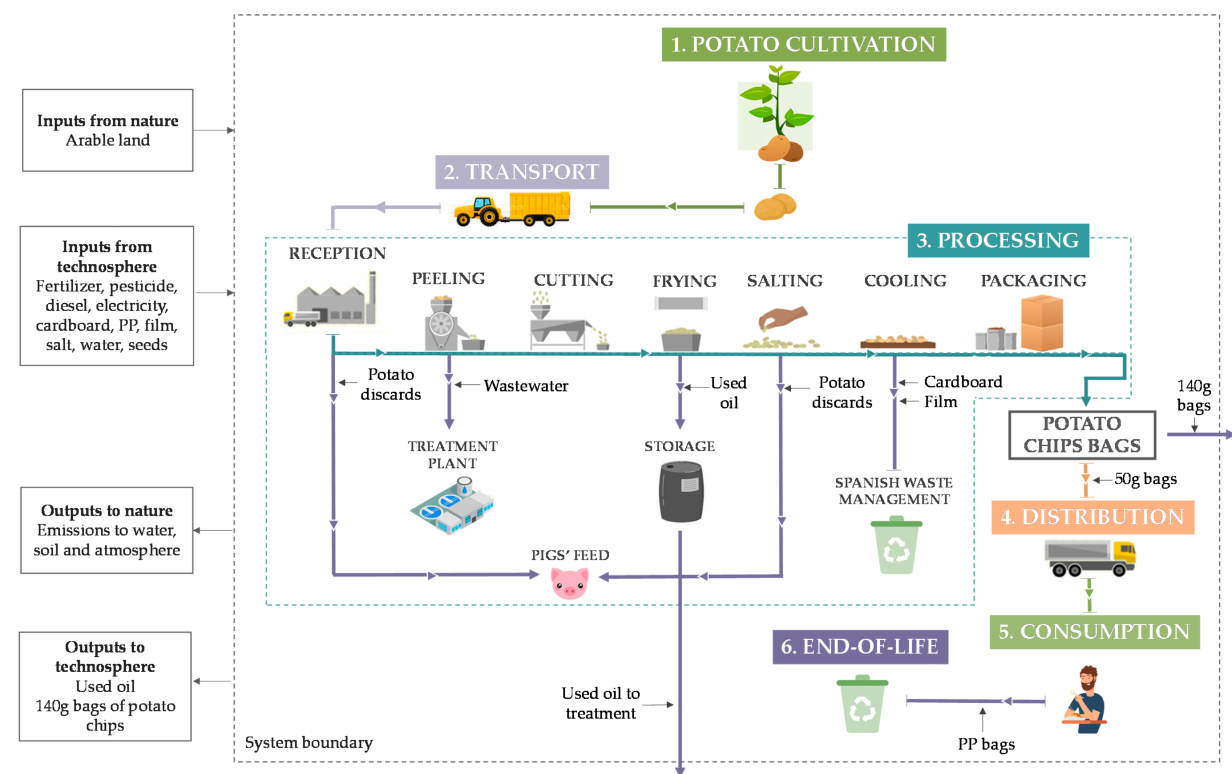
Figure 2. Flow diagram of the system under